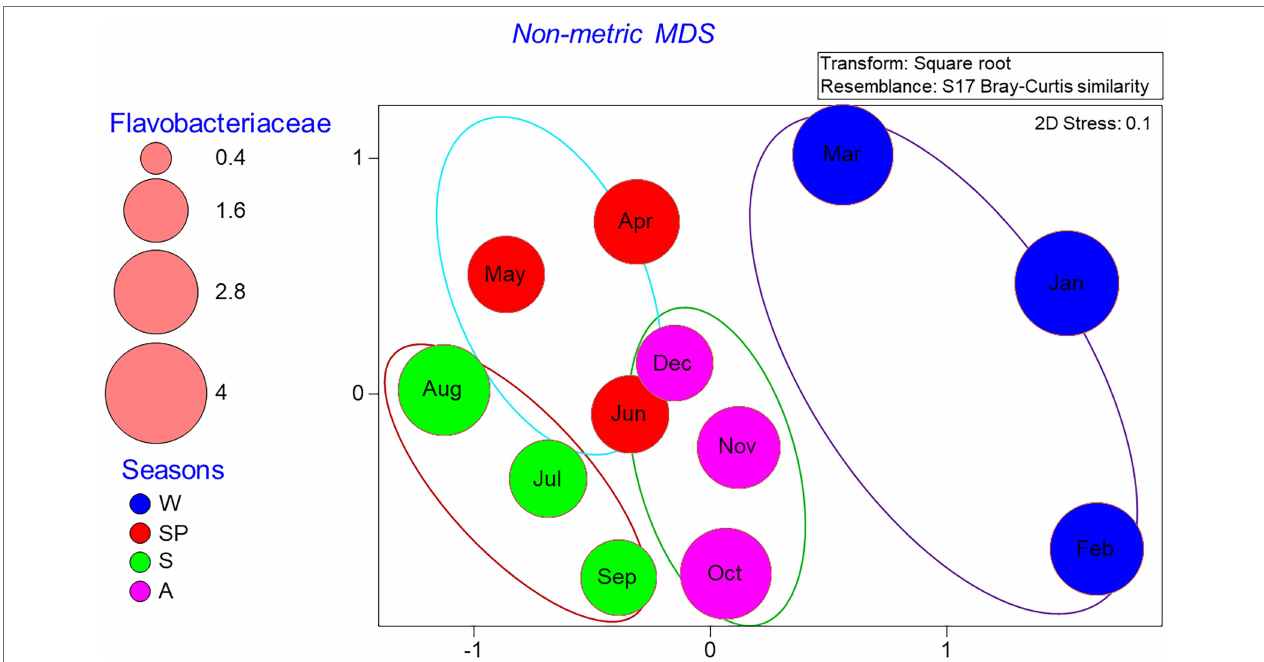
FIGURE 6 | Distribution of monthly bacterial communities in a nMDS plot in the Red Sea coastal site. The Venn diagram shows cluster overlaps within different months according to seasons. The size of the bubbles indicates the percentage of Flavobacteriaceae cells in each month of 2016, while seasons are represented by W (winter), SP (spring), S (summer), and A